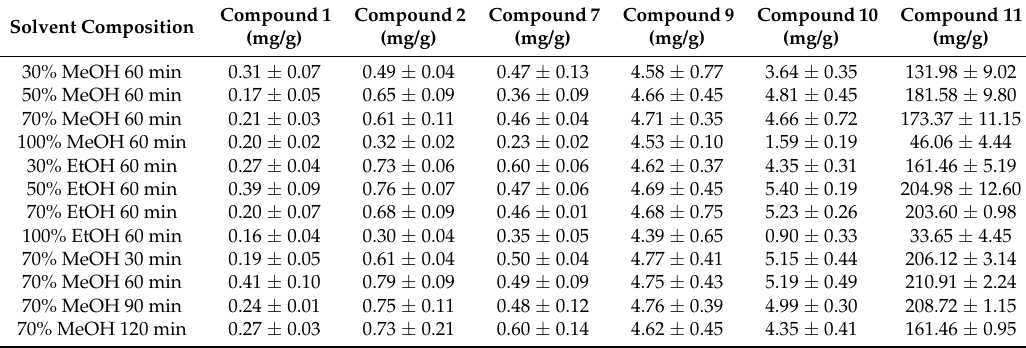
Table 4. Content of compounds 1 , 2 , 7 , 9 – 11 with respect to different solvent compositions and extraction time. MeOH: methanol; EtOH: ethanol.